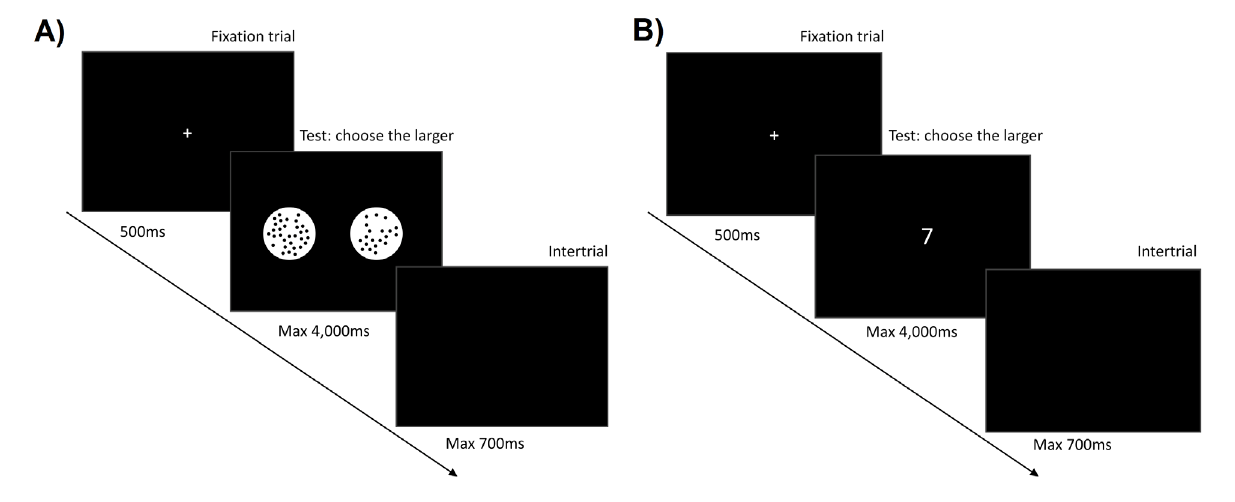
Figure 1. Illustration of experimental tasks, with arrows indicating the time curse of the tasks: fixation trial, experimental trial, and intertrial. (A) Nonsymbolic numerical magnitude comparison task and (B) symbolic numerical magnitude comparison task.